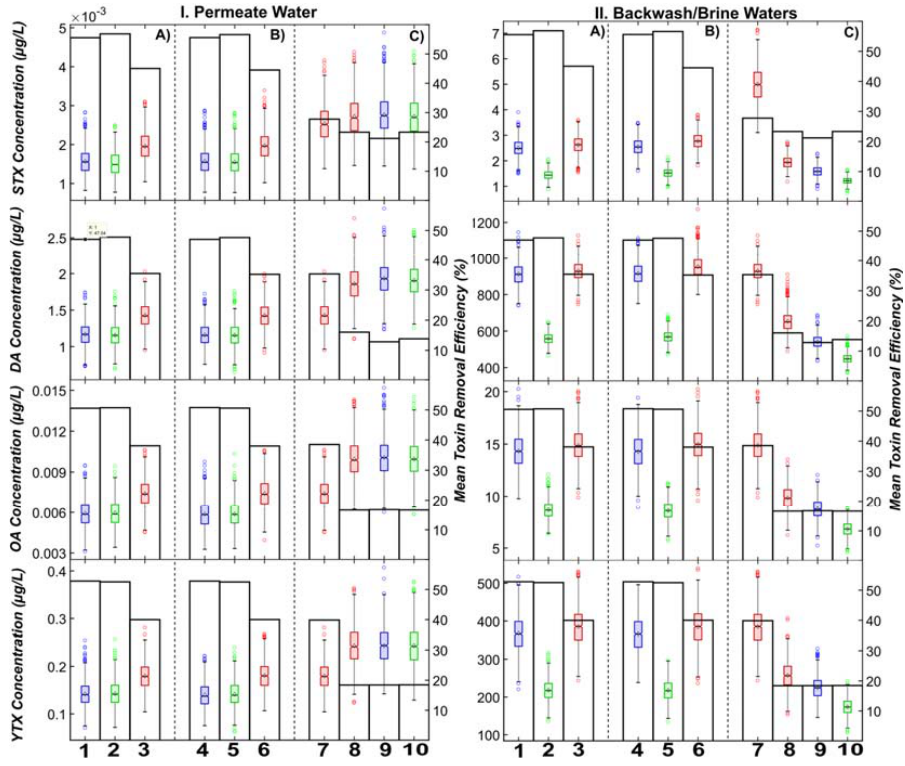
Figure 3. Toxin concentrations (colored box and whisker plot) in the I. Permeate Water and II. Backwash/Brine Waters for all treatment trains (labeled 1–10 for train T1–T10 ). Results are grouped into trains employing ( A ) DAF, ( B ) Coagulation, and ( C ) No Coagulation. Blue, green and red colors represent trains including pressurized MF/UF, vacuum MF/UF, and GMF treatment processes, respectively. The secondary y ‐ axis portrays the mean toxin removal efficiency (shown as open bars) predicted for each treatment train.